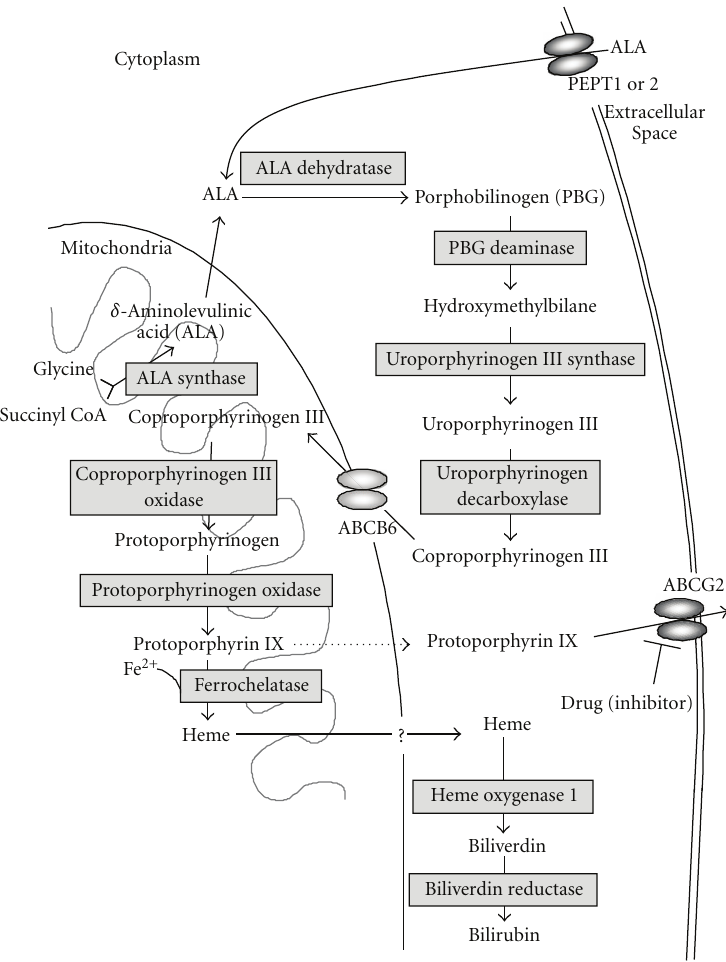
Figure 1: Schematic illustration of the biosynthesis and catabolism of heme. Rectangles indicate the enzymes involved in heme metabolism. Heme molecules are synthesized from glycine and succinyl Co-A via eight-stepped enzymatic reactions. ALA: γ -aminolevulinic acid; PBG: porphobilinogen. Heme, thus formed, is catabolized to biliverdin by the microsomal enzyme heme oxygenase 1. Biliverdin is subsequently metabolized to bilirubin by biliverdin reductase. ABC transporter ABCB6 is considered to be responsible for the import of coproporphyrinogen III into mitochondria, whereas ABCG2 transports porphyrins across the plasma membrane to maintain intracellular porphyrin homeostasis. ABCG2-mediated porphyrin transport can be inhibited by drugs, such as protein kinase inhibitors, as shown in Figure